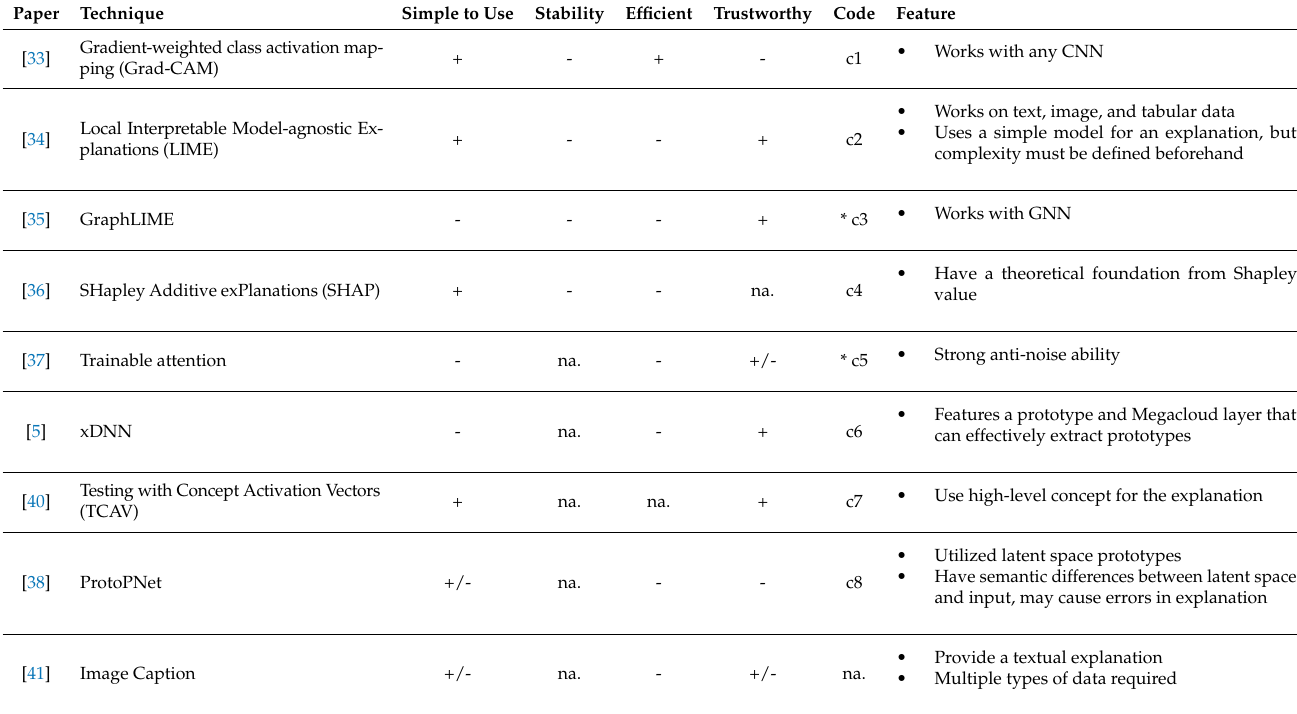
Table 3. The advantages and disadvantages of the XAI technique. The letters in Code refer to URLs in the